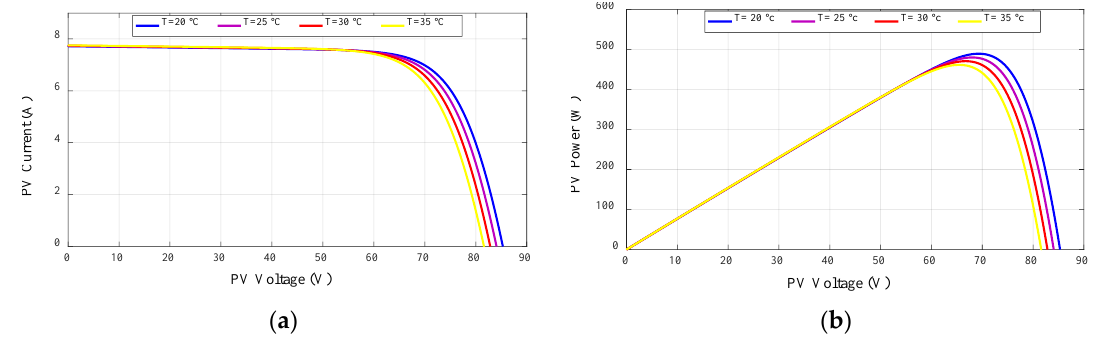
Figure 2. PV array characteristics for different solar irradiation values: ( a ) I–V; ( b ) P–V.